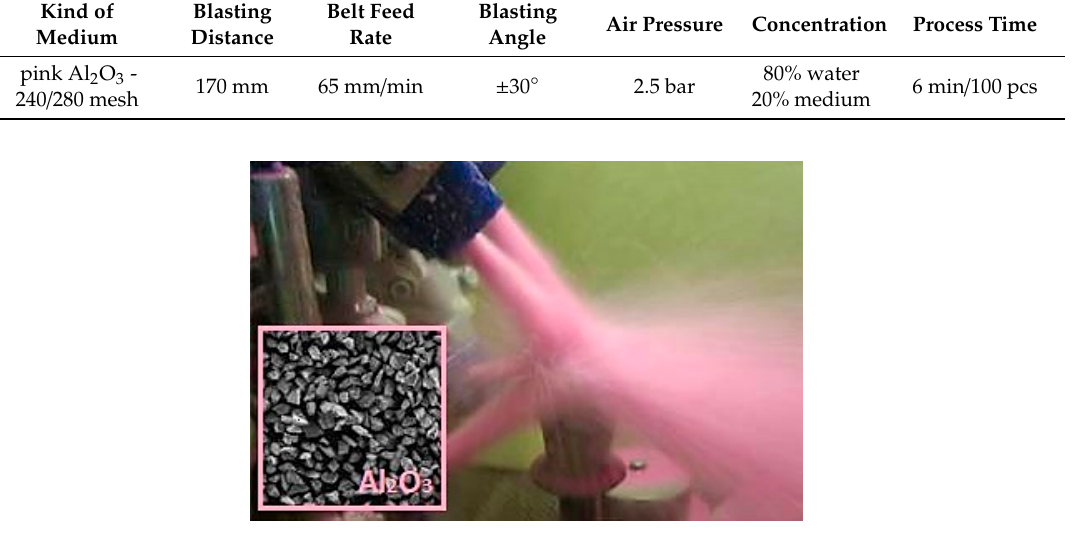
Figure 1. Abrasive jet machining process.